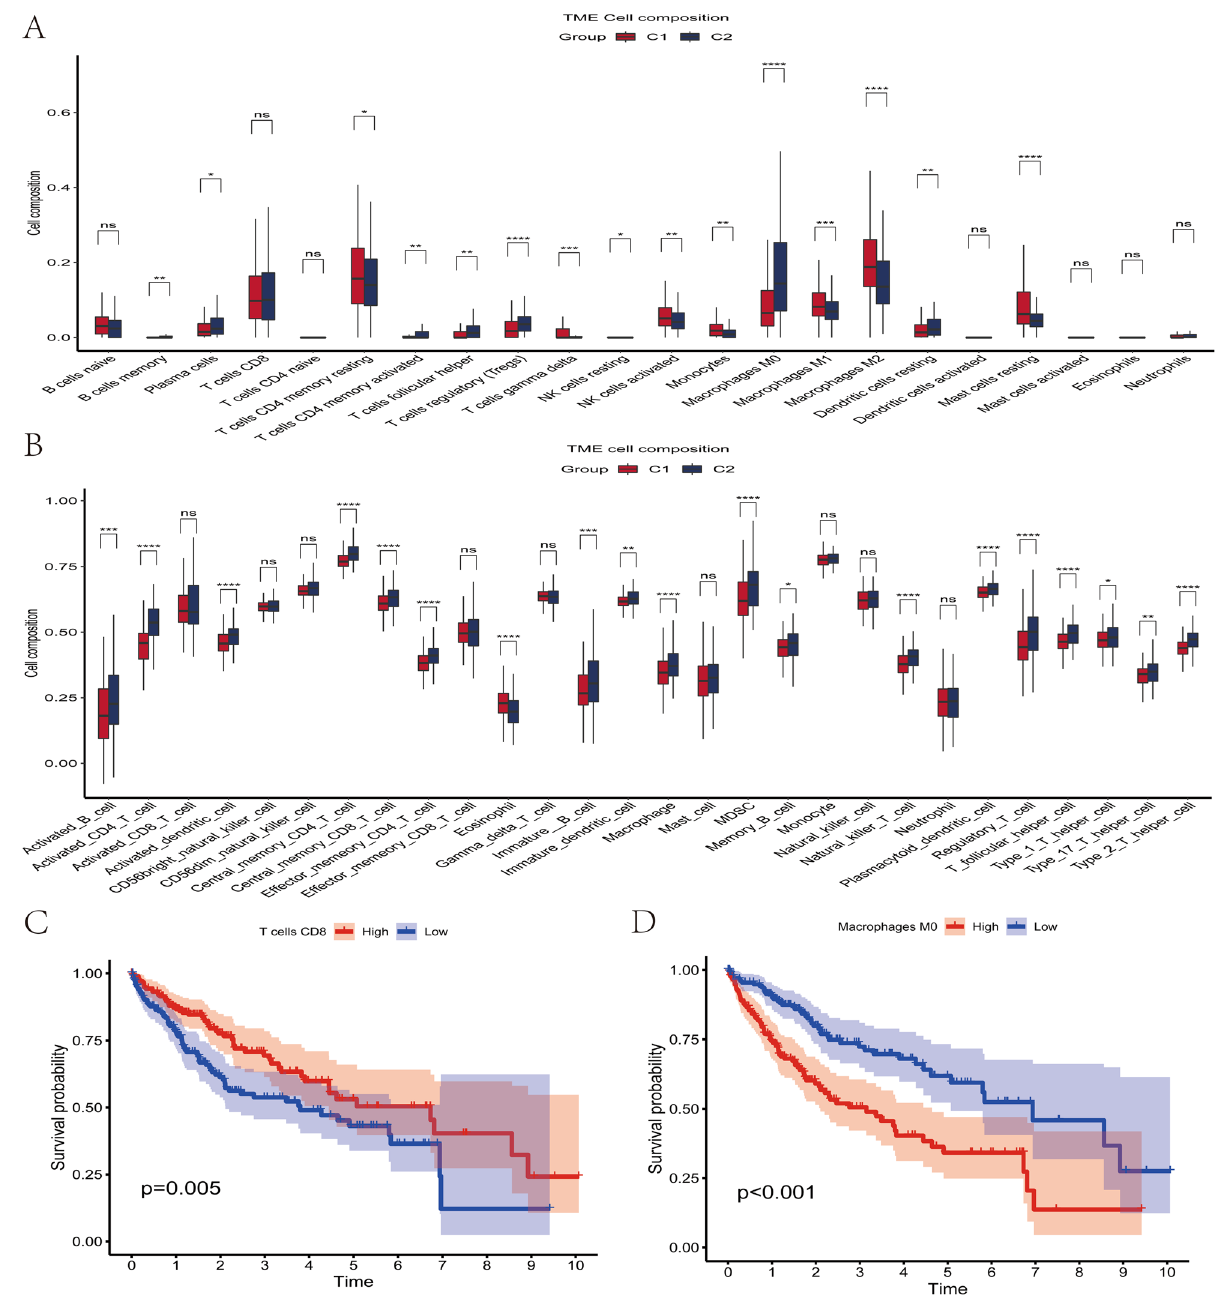
Figure 4. Analysis of immune cell infiltration in the tumor microenvironment. ( A ) Differences in the proportion of immune cell infiltration by tumor microenvironment species between clusters. ( B ) Differences in the proportion of 28 immune cell infiltrates in the tumor microenvironment between clusters. ( C ) Kaplan– Meier survival analysis showed that HCC patients in the highly infiltrated T cell CD8 group had longer overall survival compared to the low infiltrated T cell CD8 group. ( D ) Kaplan–Meier survival analysis showed that HCC patients in the highly infiltrated M0 Macrophages group had a shorter overall survival time compared to the low infiltrated group. ( E ) Kaplan–Meier survival analysis showed that HCC patients in the highly infiltrated M2 Macrophages group had a shorter overall survival time compared to the low infiltrated group. ( F ) Kaplan– Meier survival analysis showed no significant difference in overall survival time in the highly infiltrated Treg cell group compared to the low infiltrated group of HCC